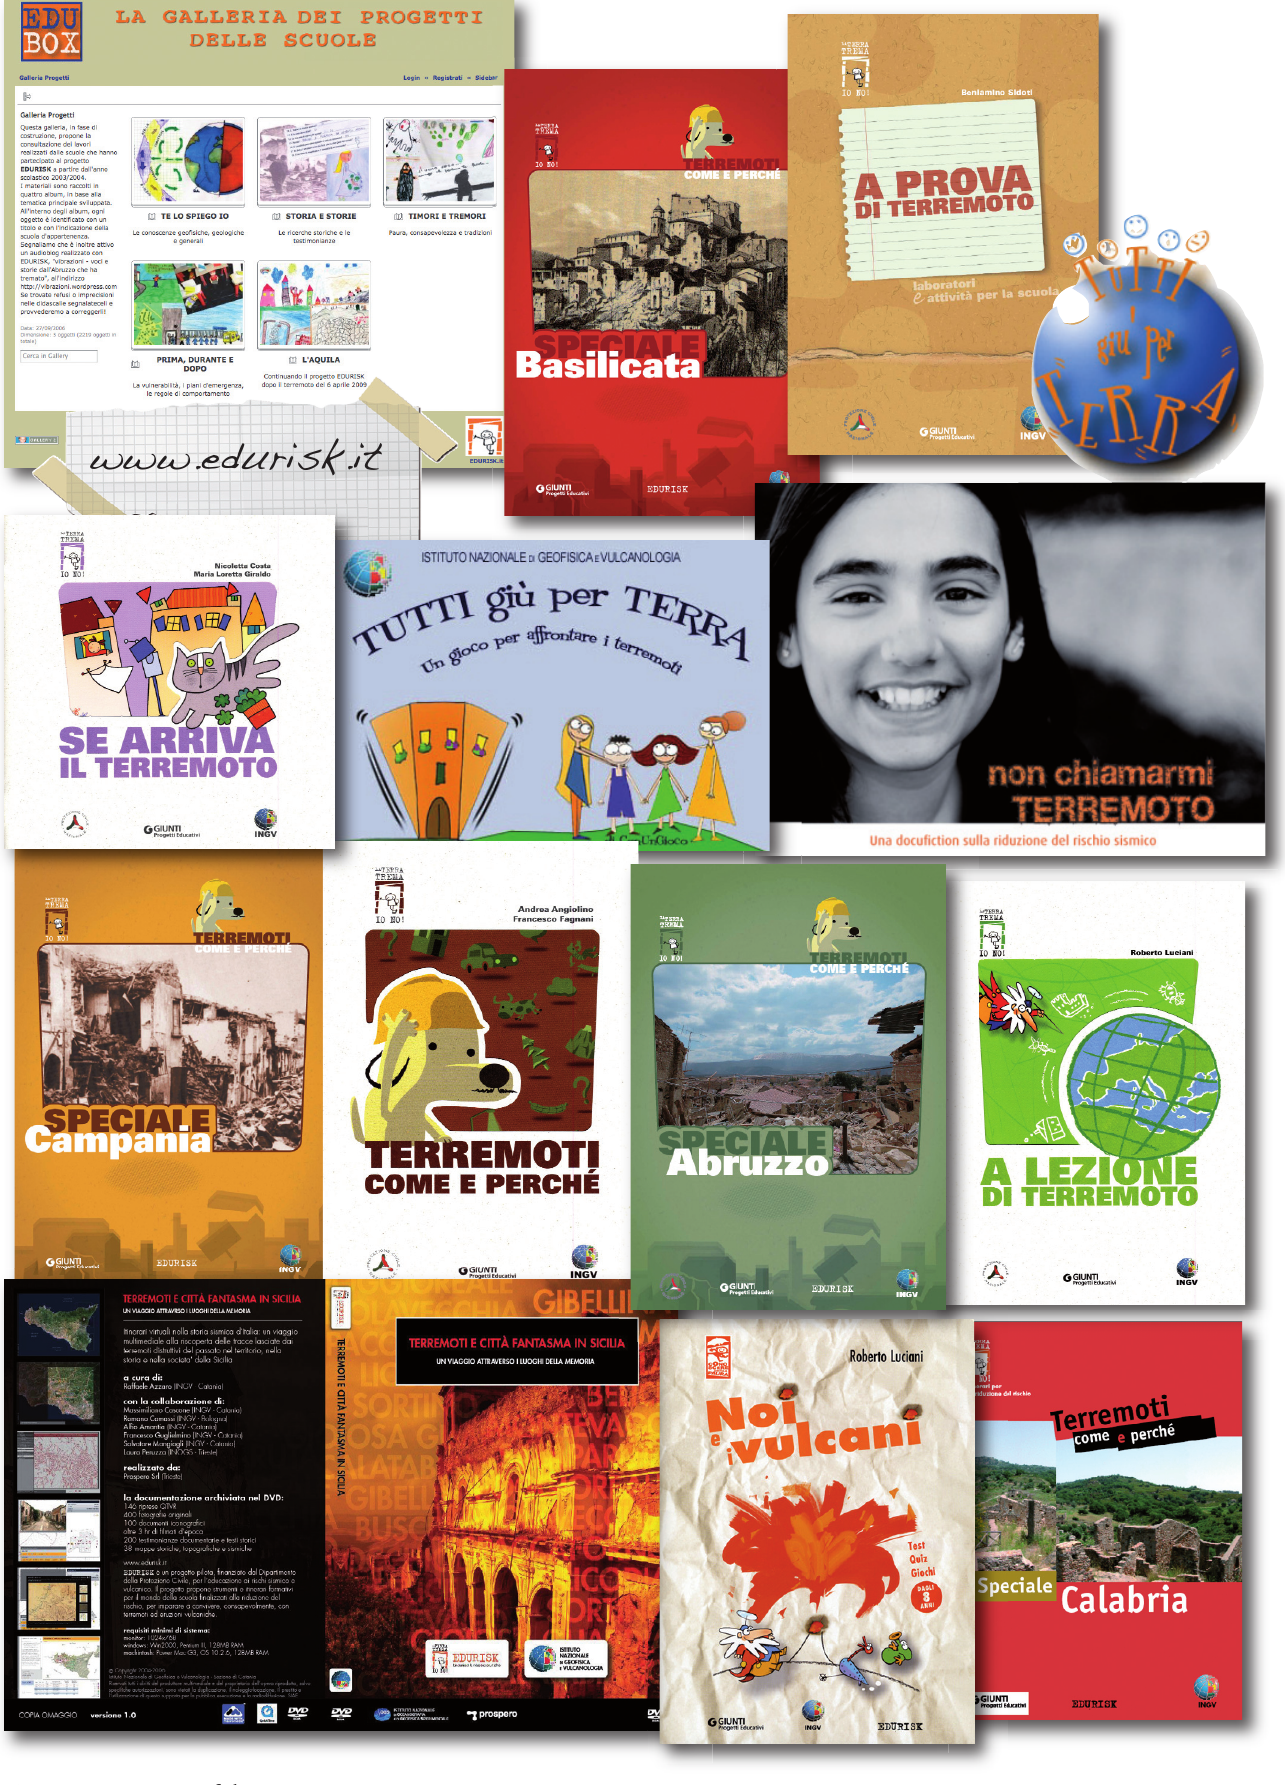
Figure 3. Instruments of the EDURISK